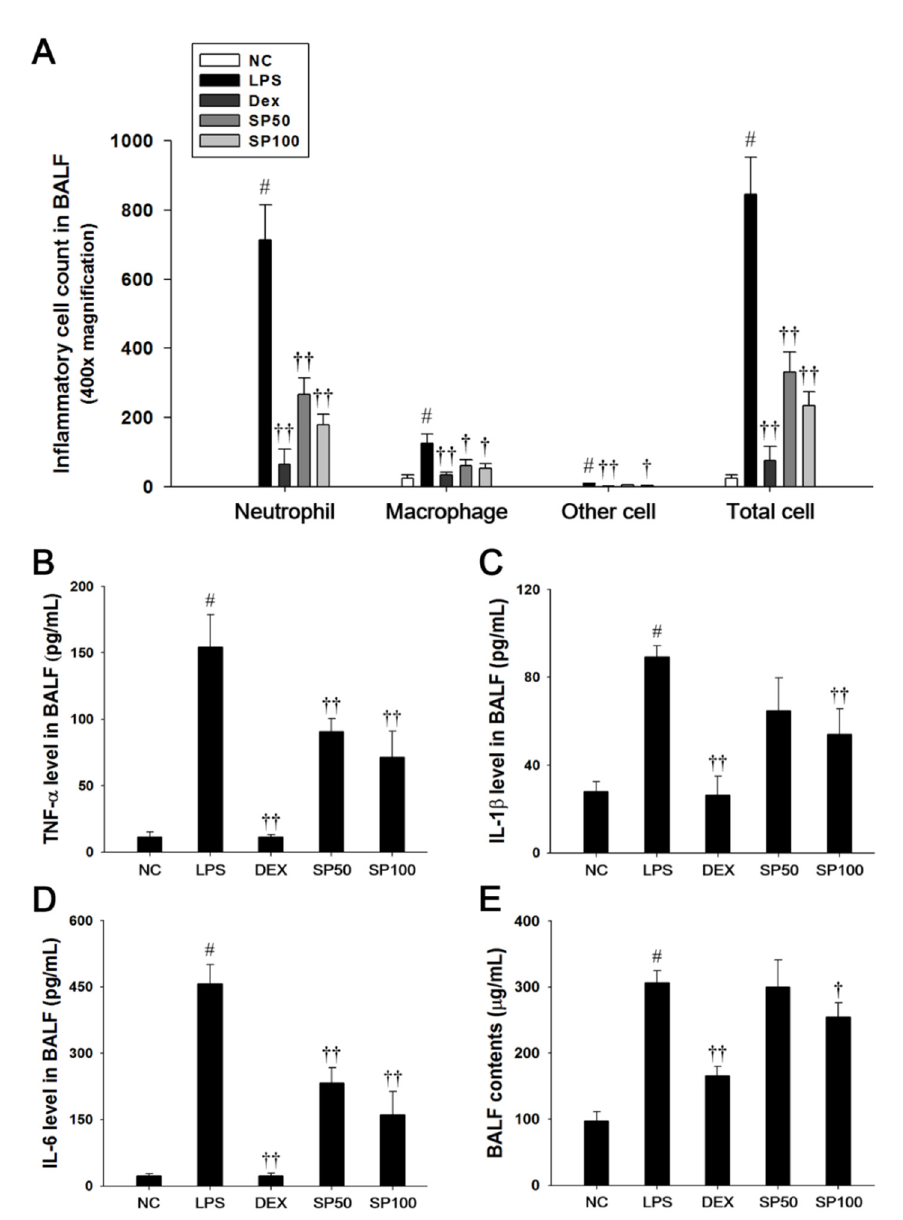
Figure 2. E ff ects of SP on inflammatory cell number, pro-inflammatory cytokines, and protein contents in the bronchoalveolar lavage fluid (BALF). ( A ) Inflammatory cells were counted by Di ff -Quik stain reagent. ( B ) Tumor necrosis factor (TNF)- α , ( C ) interleukin (IL)-1 β , and ( D ) IL-6 production in the BALF were determined by ELISA. ( E ) BALF protein contents were assessed by Bradford reagent. NC: normal control mice; LPS: LPS-induced mice; DEX: dexamethasone (3 mg / kg) + LPS-induced mice;